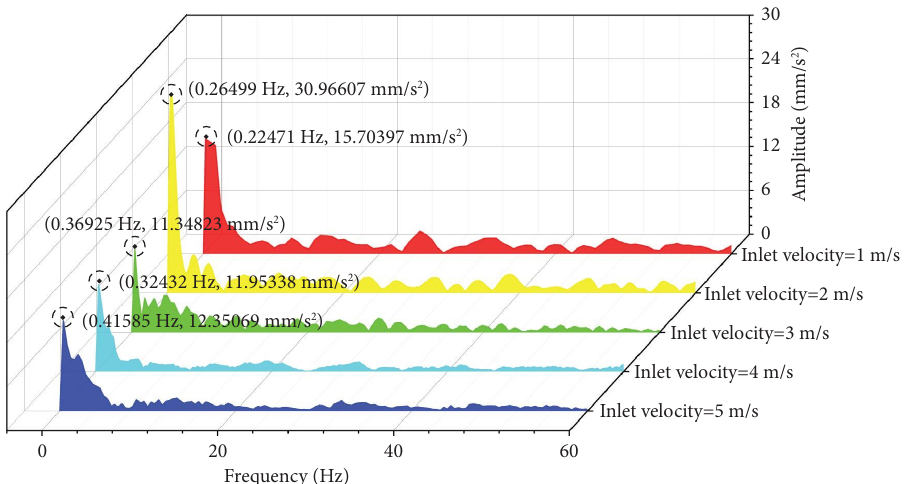
Figure 18: Te frequency-domain diagram of the vibration response of monitoring point B at diferent inlet